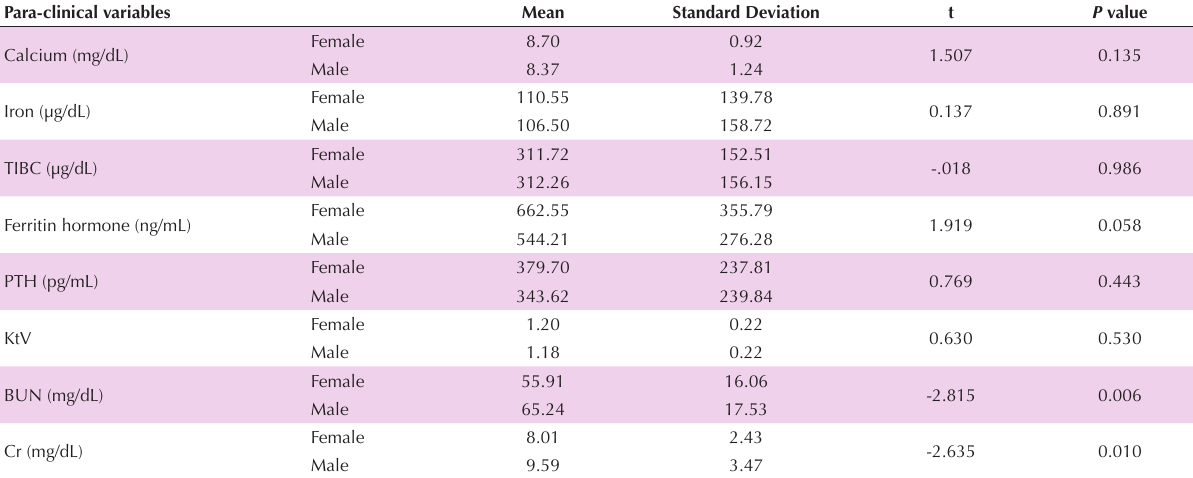
Table 3. Para-clinical characteristics of the patients undergoing hemodialysis across both genders Para-clinical variables